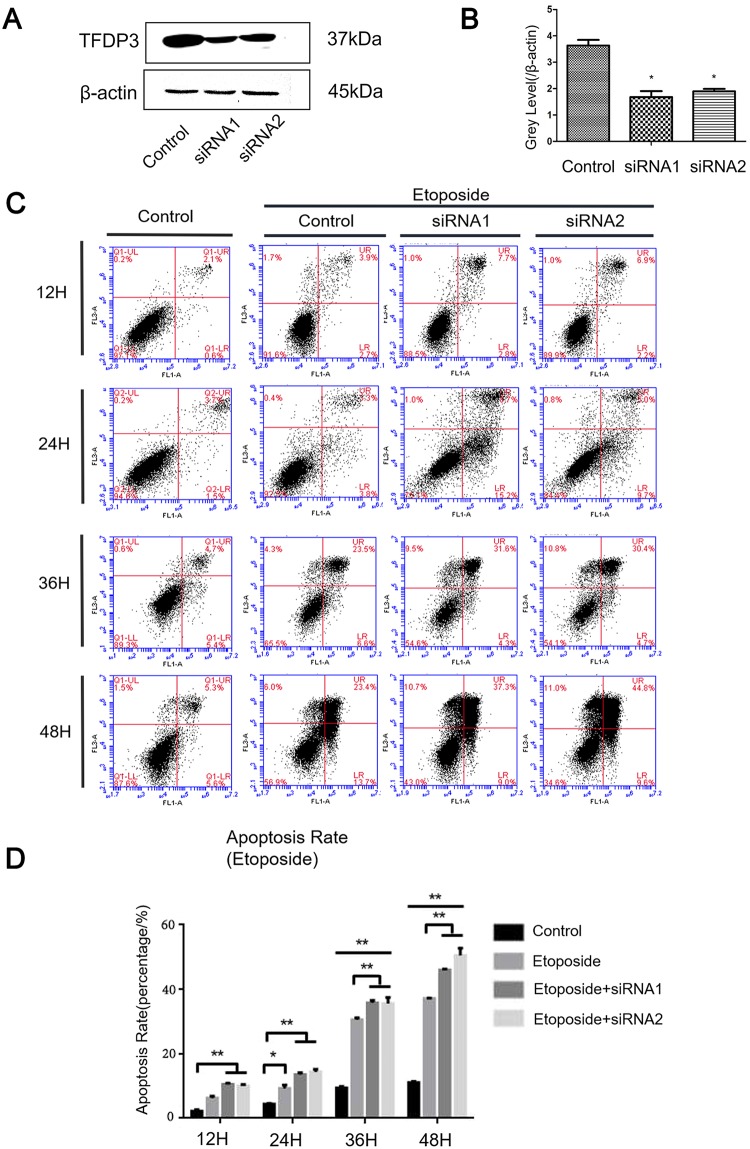
The expression of TFDP3 in siRNA interfered with MDA-MB-231 cancer cell line.A, Western Blot examined knockdown efficiency of TFDP3 by siRNA in MDA-MB-231 cells; B, Image-Pro Plus was used to analyze the gray scale value of Western Blot, and to calculates a relative gray value (TFDP3/β-actin) (n = 6). The results confirmed the expression of TFDP3 in specific siRNA transfected group decreased dramatically; C, Apoptosis rate of siRNA transfected cells with or without 1μM etoposide treatment after 24 hours, 36 hours and 48 hours; Flow cytometry was used examine the apoptosis; D, Histogram of the apoptotic rate (n = 5). Multivariate analysis of variance was performed to analyze significance against the control group, p <0.01.